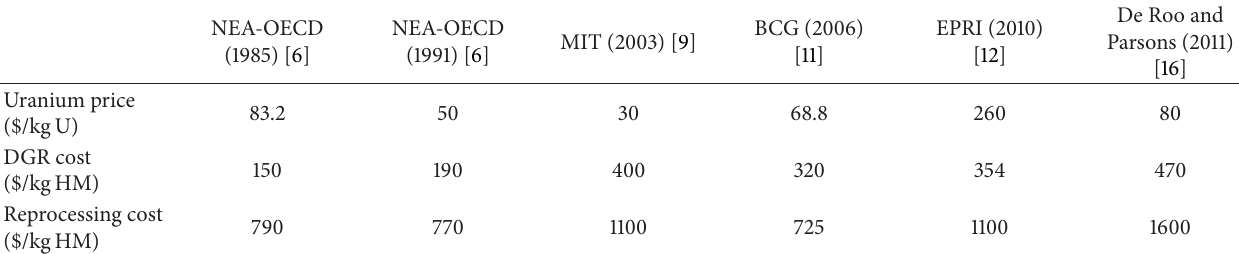
Table 1: Results from the studies.